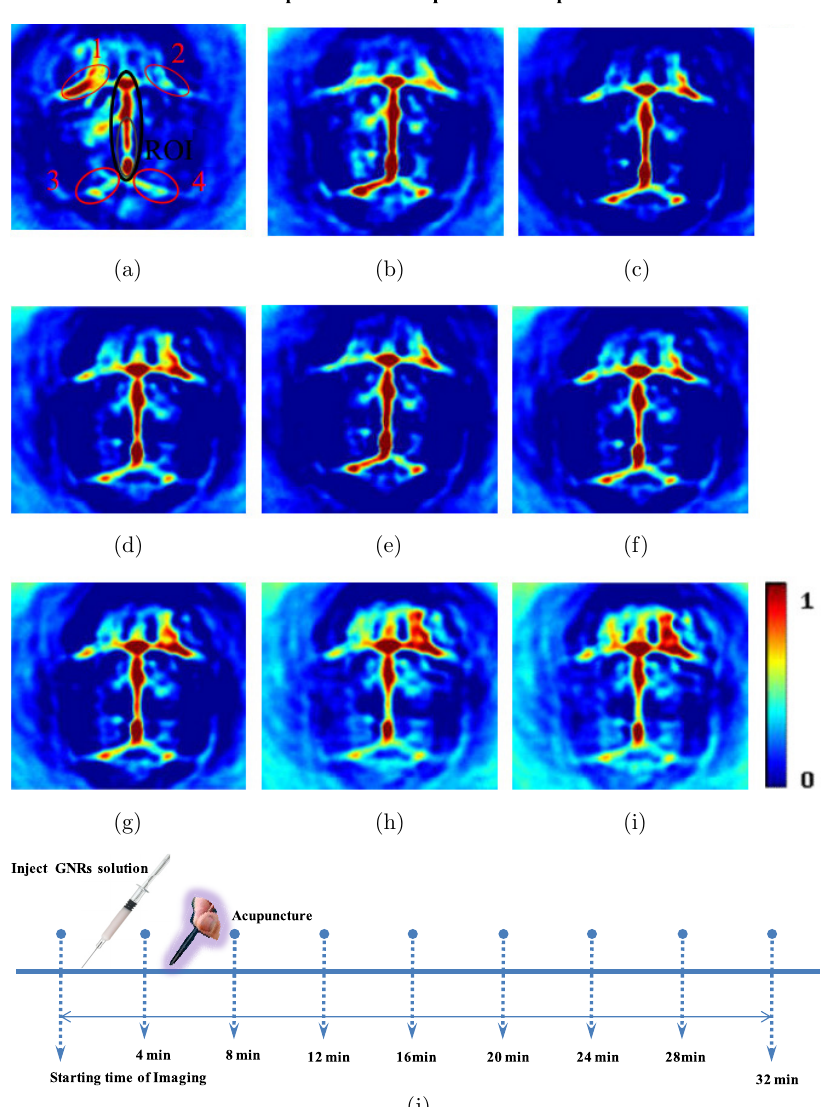
Fig. 5. (a) – (i) Nine in vivo PAT brain reconstructed images of the cerebral vasculature of a mouse brain prior to GNRs injection (a), 4 min post injection and prior to acupuncture (b), and 4 min – 28 min post acupuncture (c) – (i) in Group III. (j) Experimental timeline for Group